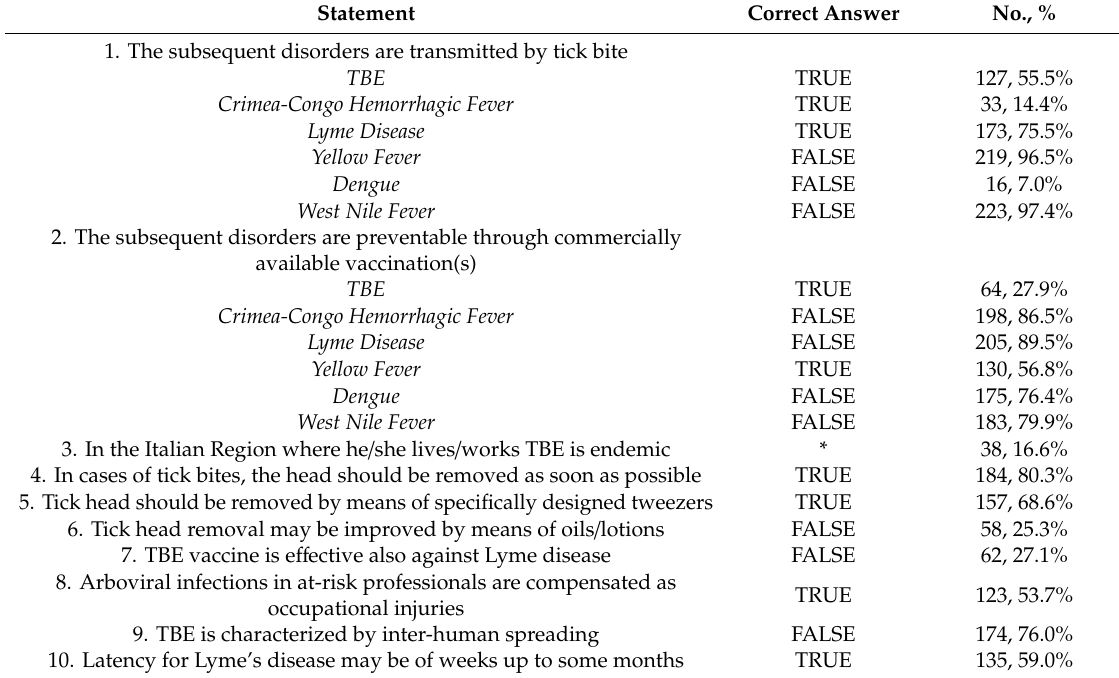
Table 2. Knowledge test: response distribution of presented items proposed to the 229 Occupational Physicians participating in the survey and contributing to the assessment of General Knowledge Score (GKS) (Cronbach’s Alpha =